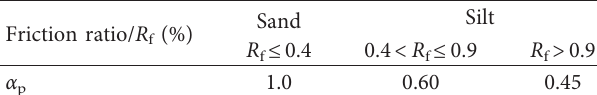
Table 8: Soil correction coefficients